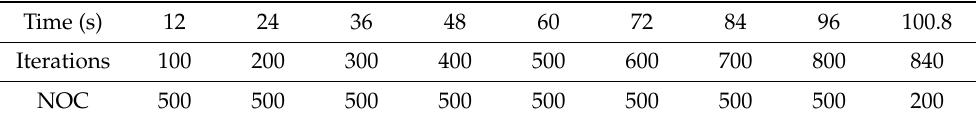
Table 7. Number of channels per 100 iterations